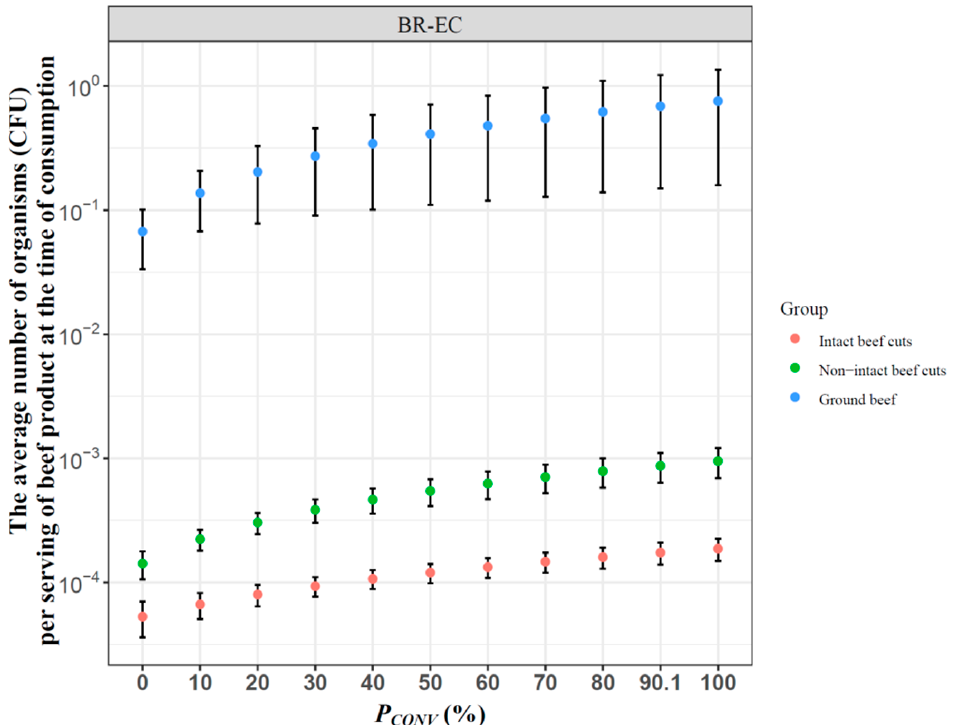
Figure 2. Impacts of antibiotic use in U.S. beef cattle agrisystems on the average number (± standard error) of BR-EC per serving of intact beef cuts, non-intact beef cuts, and ground beef (CFU/serving) at the time of consumption. Baseline: P CONV = 90.1%, referring to the percentage of cattle raised with antibiotics in the U.S.